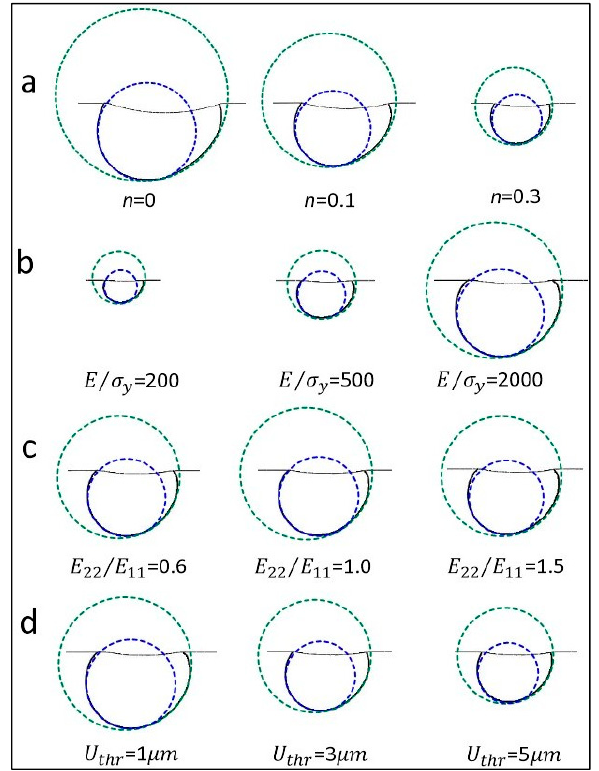
Figure 10. Influence of the strain hardening exponent, yield strain, elastic anisotropy, and the selected displacement threshold value on the relative position between two approximation circles (for all the simulations in this figure, R 22 is fixed at 1.5).